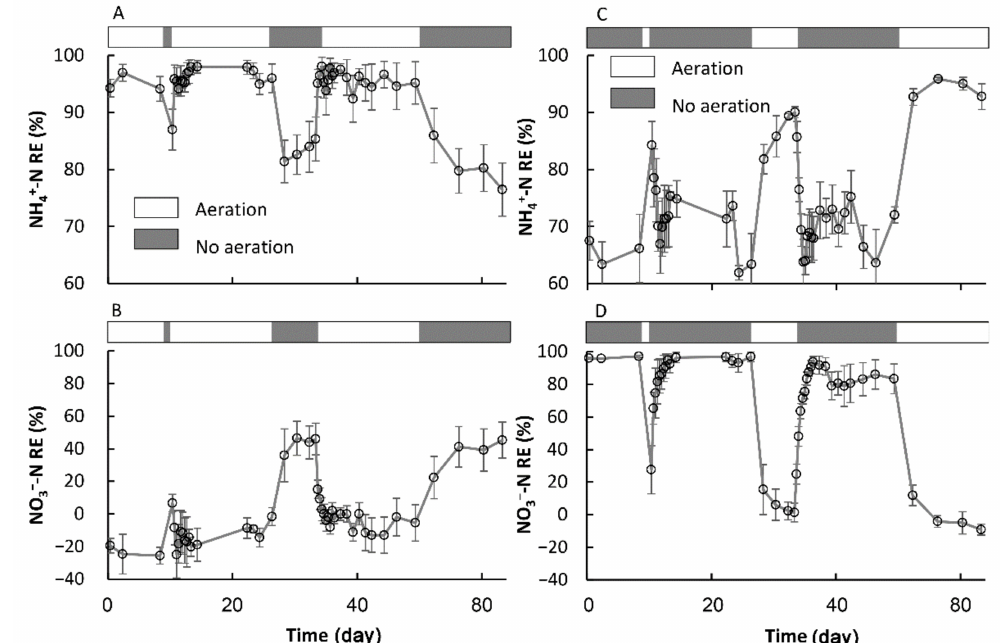
Figure 4. The fluctuations in the NH 4+ -N and NO 3 − -N removal efficiencies with the transformation from aeration to no aeration in the AE-D ( A , B ) and AN-D reactors ( C , D ). (sample number: 44).